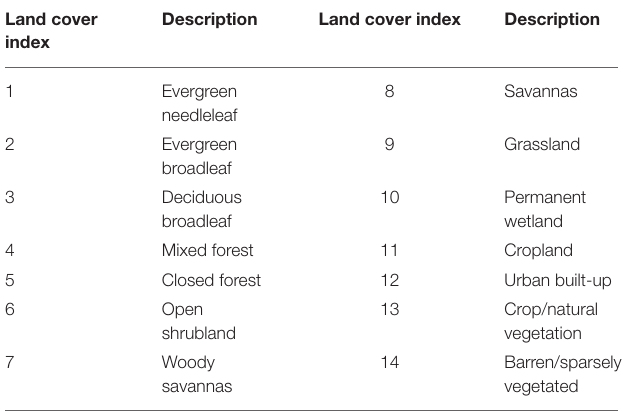
TABLE 2 | Average correlation coefficient by country for between Noah, VIC, and CLSM